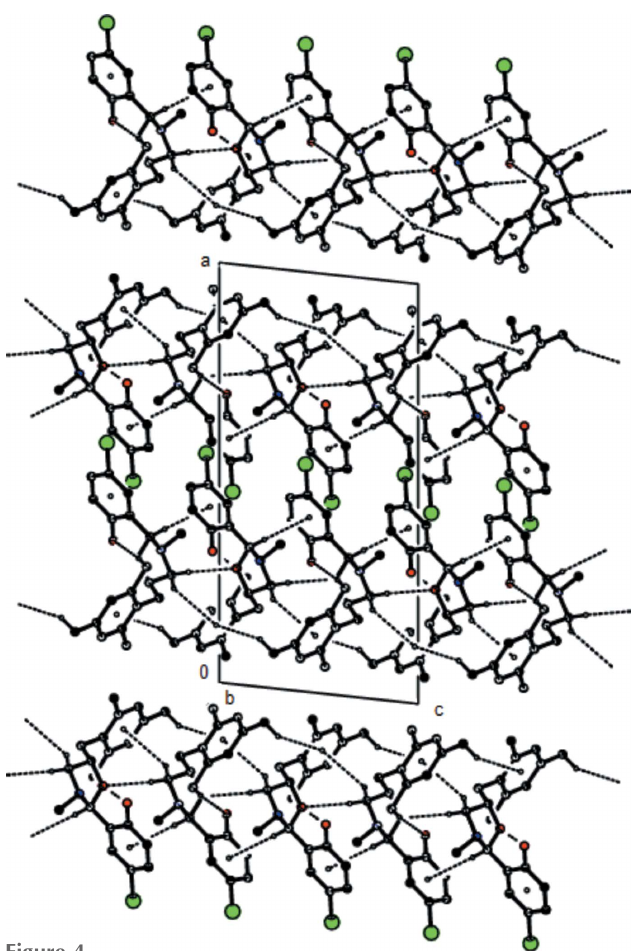
Figure 4 Packing view of the title compound along the b axis with the interactions depicted as in Fig.